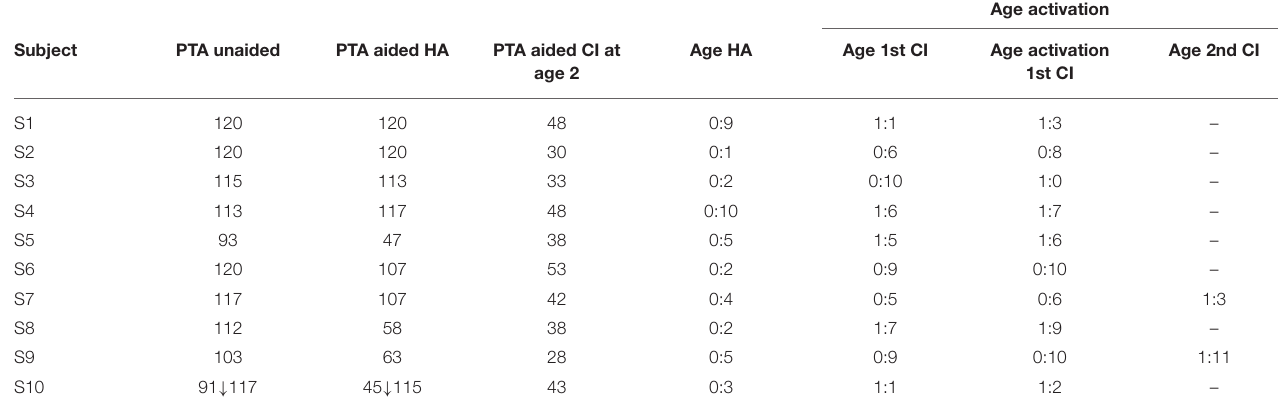
TABLE 1 | Characteristics of children with cochlear